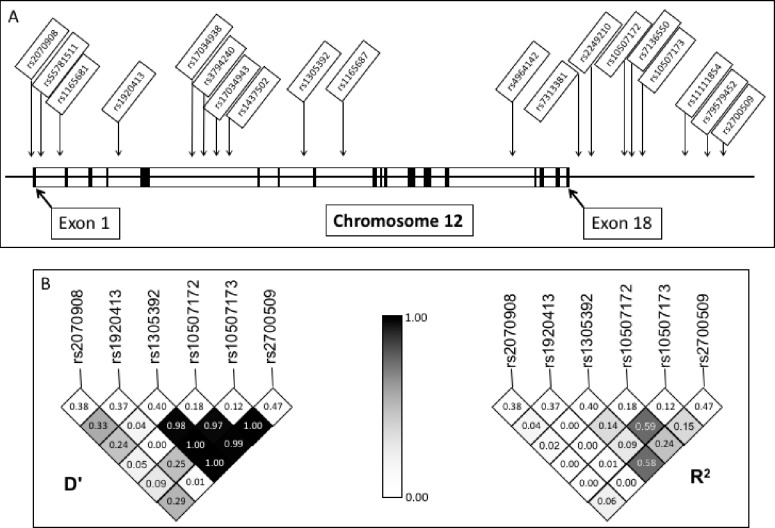
SNP selection and linkage disequilibrium.Haplotype-tagging SNPs included in our study are shown with their location relative to the HSP90B1 gene (A). Measures of linkage disequilibrium by D’ and R2 are shown for selected SNPs (B).